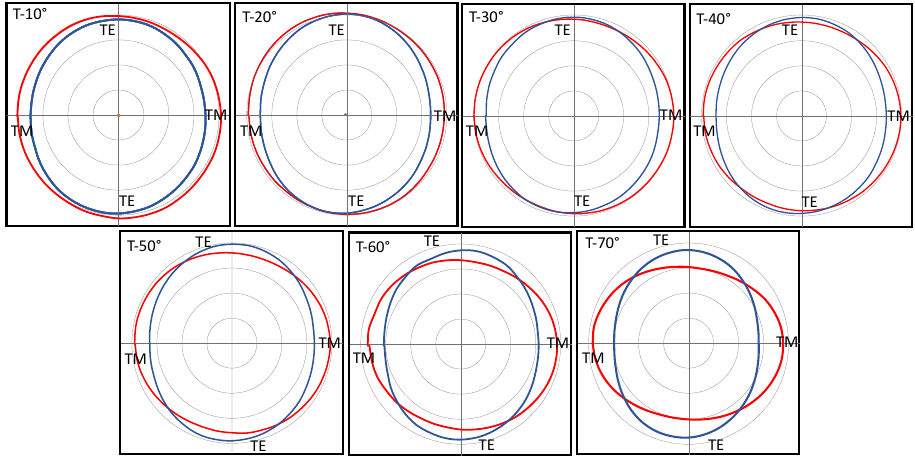
Figure 4. Polar distributions of Teflon radiances for polarizations parallel (red) and orthogonal (blue) to the input one. Images report the measured radiances varying the observation azimuthal angle θ view .